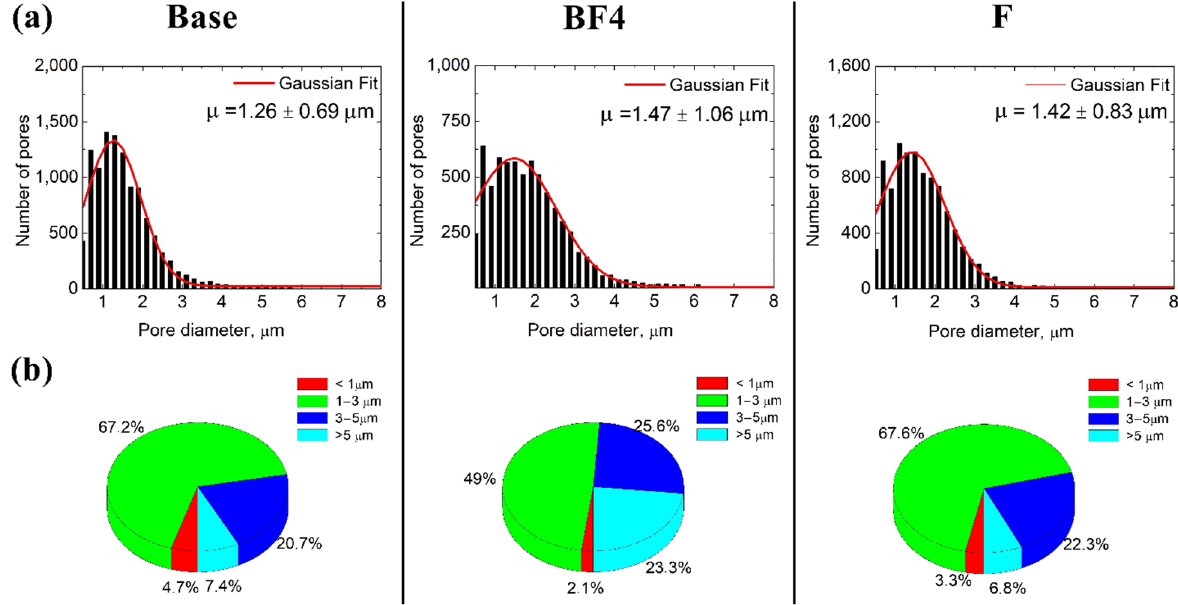
Figure 3. Analysis of the morphology of PEO coatings in various electrolytes: ( a ) pore size distribution; ( b ) percentage pore size distribution.